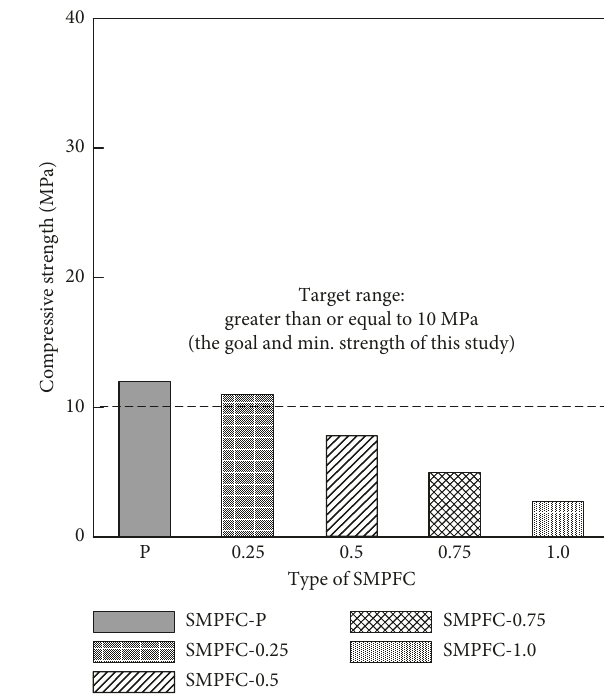
Figure 5: Test results of compressive strength